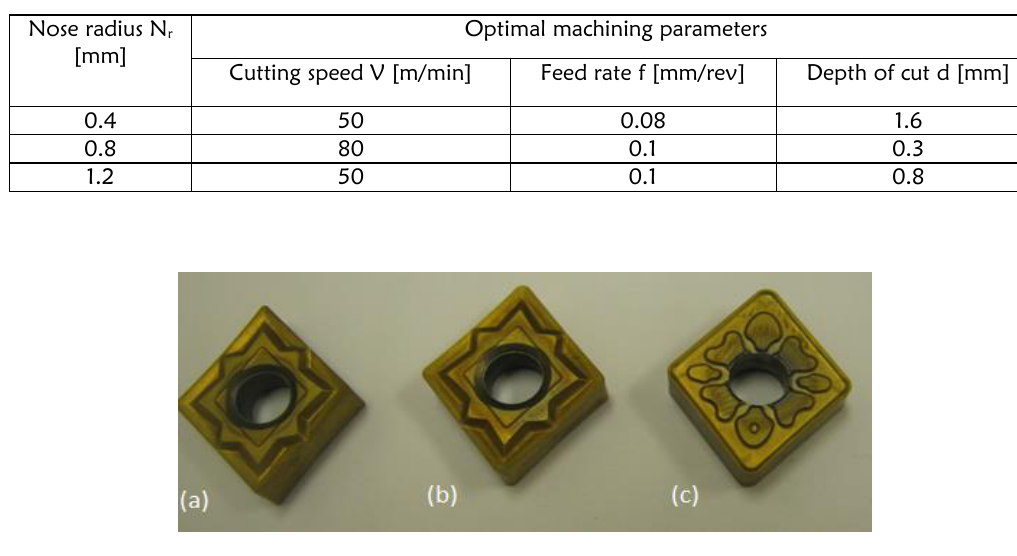
Figure 6: Coated carbide inserts